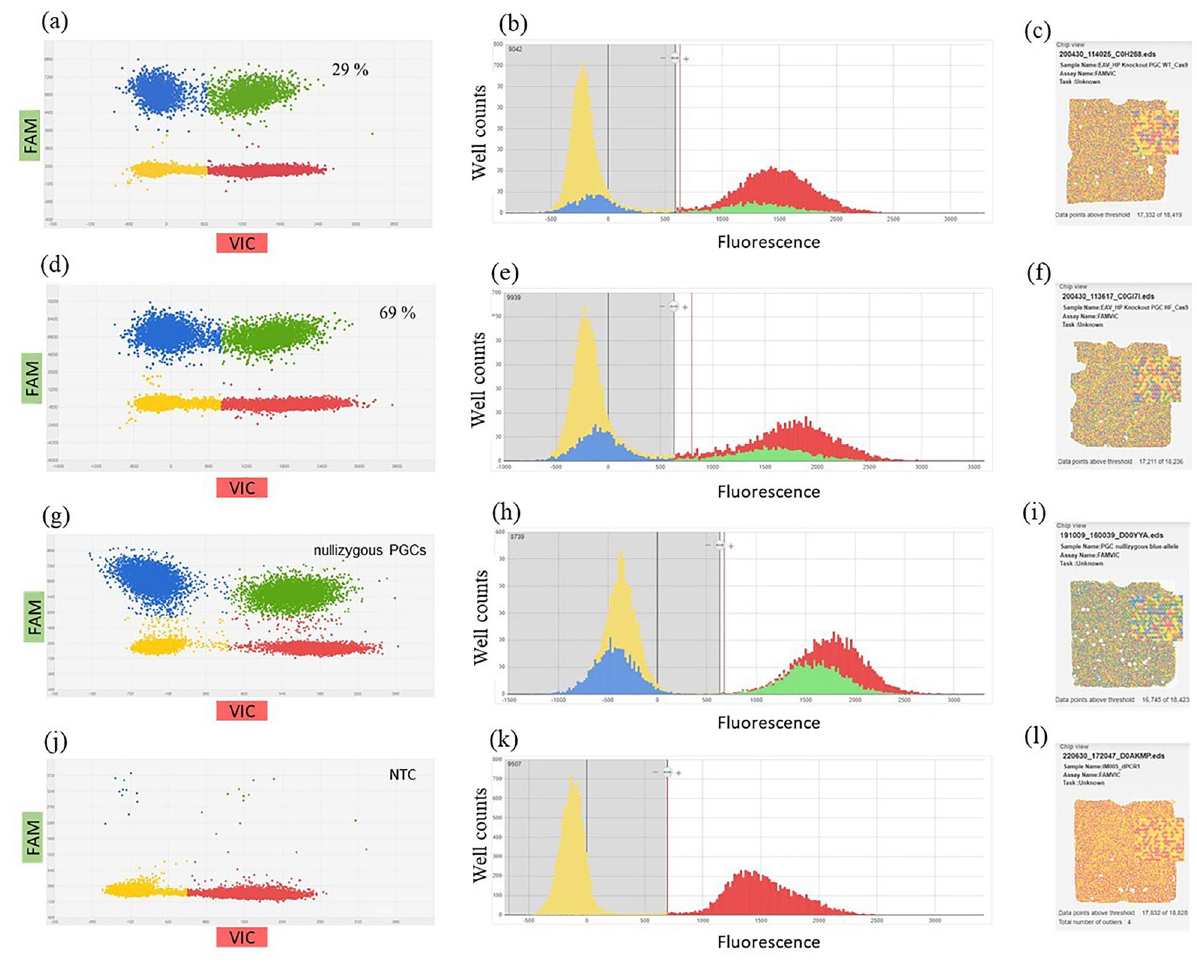
Figure 3. Digital PCR of nullizygous blue-allele PGCs, mixed knock-out cell populations and a non-target control (edited and non-edited cells, digital PCR 1). ( a,b,d,e,g,h,j,k ): blue: FAM reporter dye signal, red: VIC reporter dye signal, green: FAM/VIC reporter dye signals, yellow: no amplification (DNA-empty wells), VIC: reference assay (β-actin), FAM: digital PCR 1. ( a ) Two-dimensional scatterplot of digital PCR duplex assay (FAM/VIC) and ( b ) histogram from PGCs (knock-out approach in homozygous blue-allele bearing PGCs from Araucana chickens (mixed cell population), wildtype Cas9); ( c,f,i,l ) chip view by calls (uniformity). ( d ) scatterplot of digital PCR duplex assay (FAM/VIC) and ( e ) histogram from PGCs (knock-out approach in formerly homozygous blue-allele bearing PGCs from Araucana chickens (mixed cell population), high- fidelity Cas9); ( g ) scatterplot of digital PCR duplex assay (FAM/VIC) and ( h ) histogram from PGCs (control: nullizygous blue-allele bearing PGCs, no EAV-HP insertion on chr. 1); ( j ) scatterplot of digital PCR duplex assay (FAM/VIC) and ( k ) histogram from PGCs [ NTC non-target control (FAM), homozygous blue-allele bearing